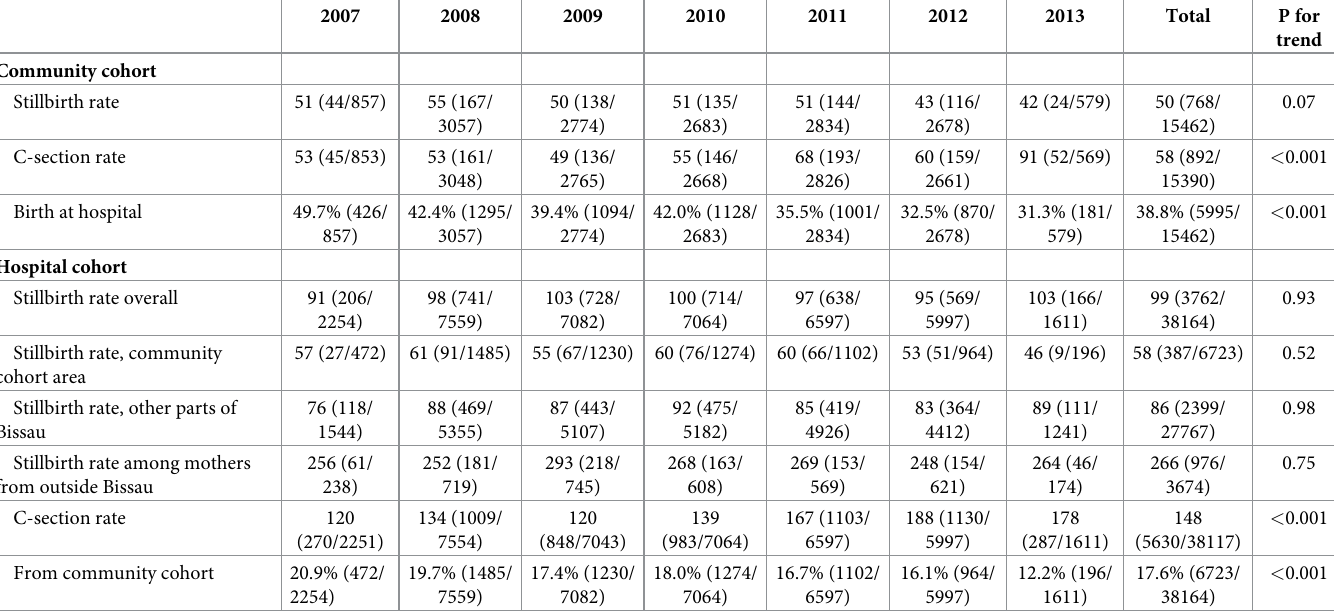
Table 2. Stillbirth and caesarean section rates in the community and hospital cohorts.